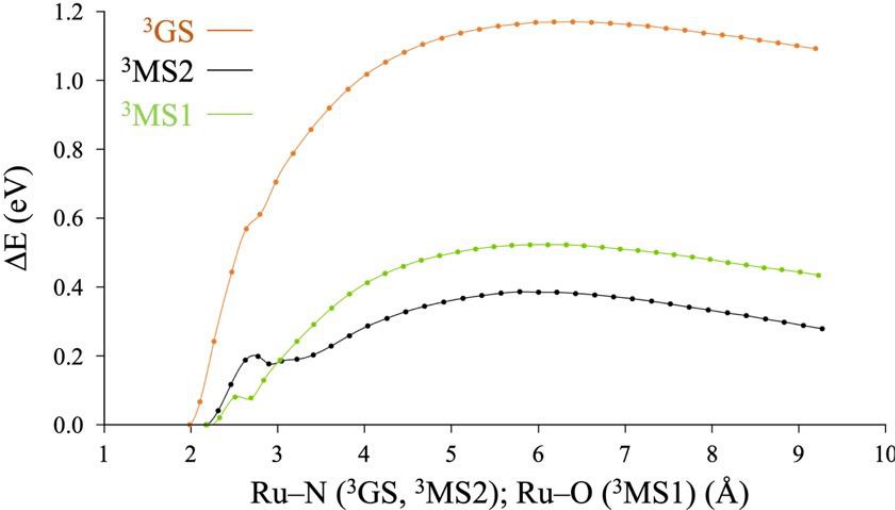
Figure 3. Minimum energy paths for NO dissociation in the trans -[RuCl(NO)(py) 4 ] 2 + complex at the B3LYP-D3 level of theory from the three triplet excited states 3 GS, 3 MS2 and 3 MS1. The zero energy is set to the triplet energy of the 3 GS, 3 MS2 and 3 MS1 at their respective minima for each curve. Adapted with permission from Ref. [50].